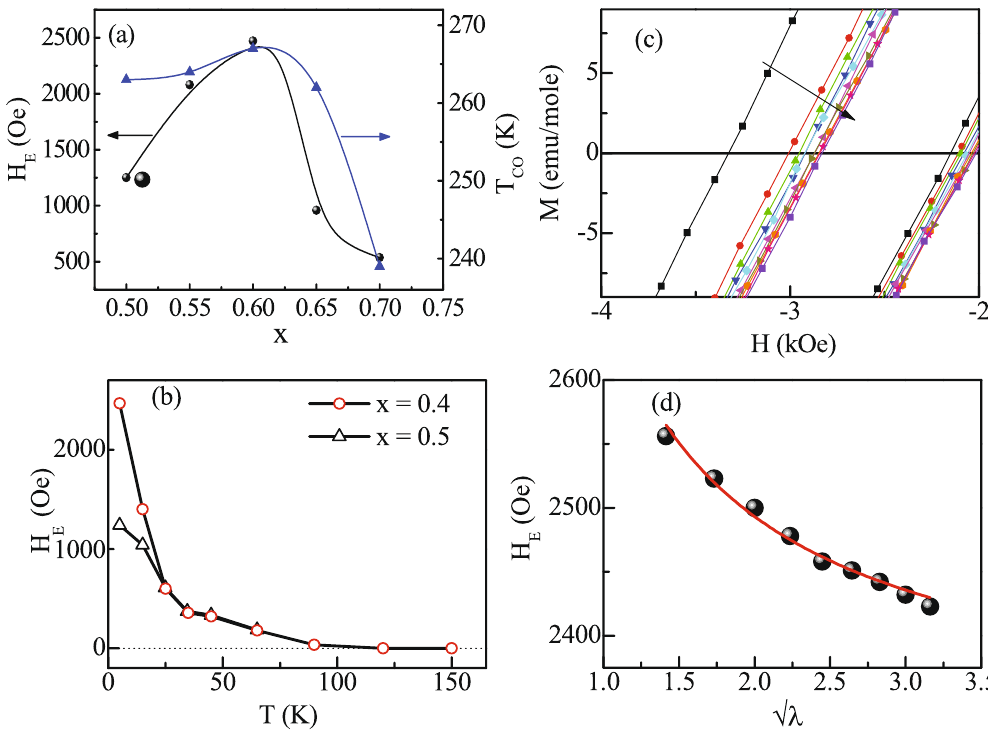
Figure 4. ( a ) Variation of H E and T CO as a function of Ca-concentration (x). ( b ) Variation of H E with temperature in bulk Sm